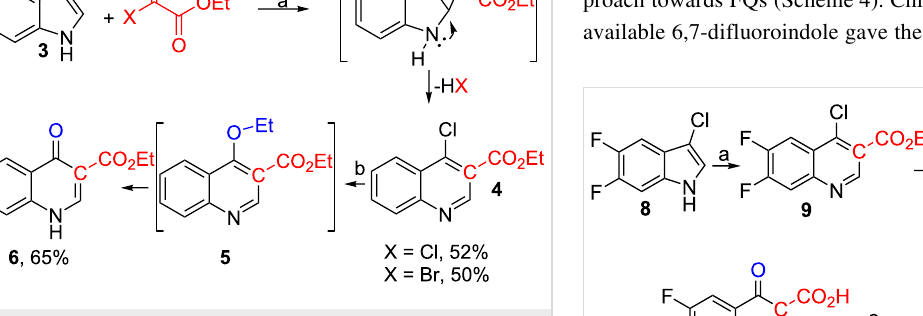
Scheme 3: Synthesis of ethyl 4-quinolone-3-carboxylate ( 6 ) and pro- posed mechanism. a: Rh 2 (esp) 2 (1 mol %), CH 2 Cl 2 , rt, Cs 2 CO 3 , 50–52%. b: EtOH, reflux, 24 h,